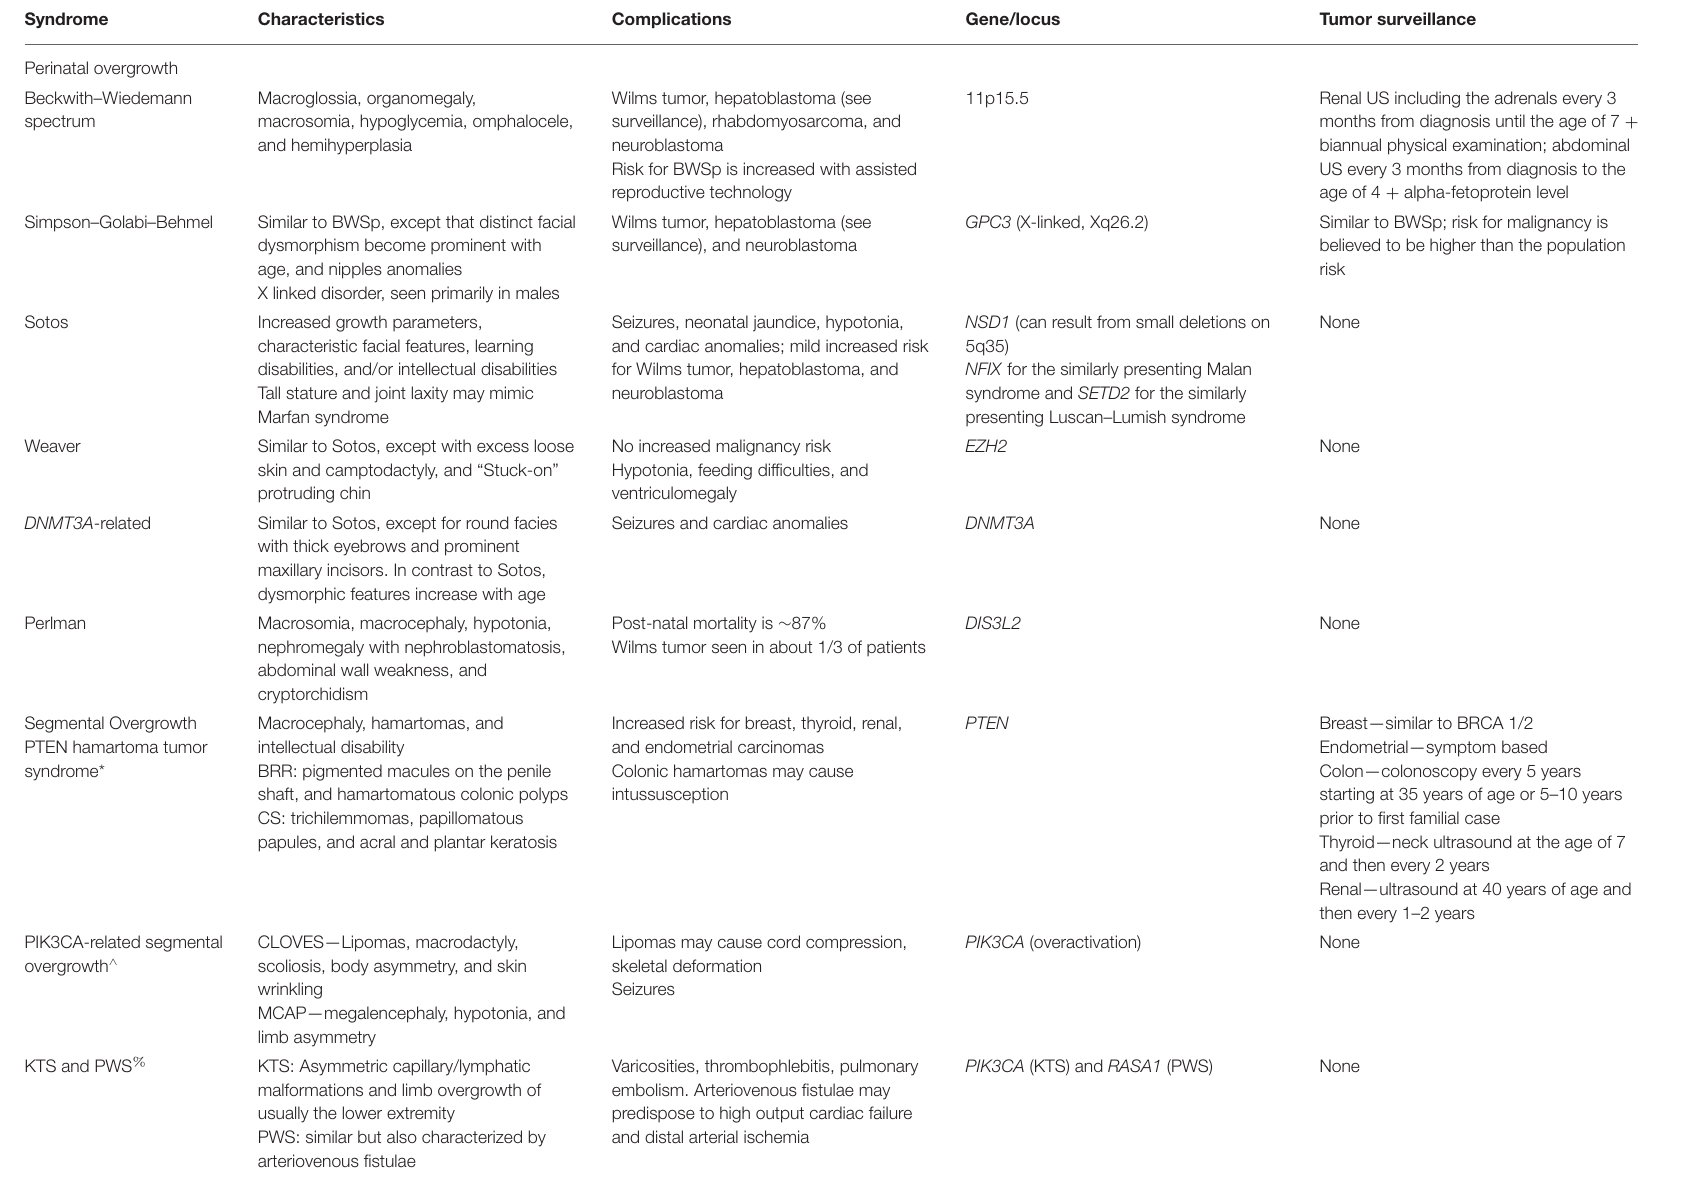
TABLE 2 | Types of overgrowth